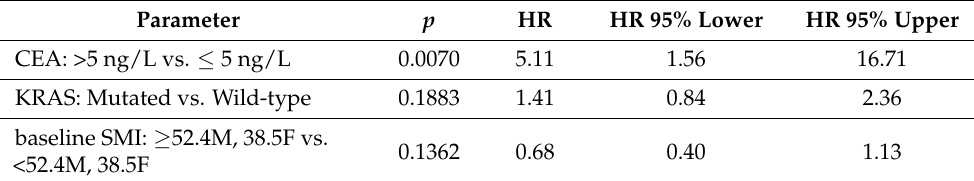
Table 4. Multivariate analysis of progression free